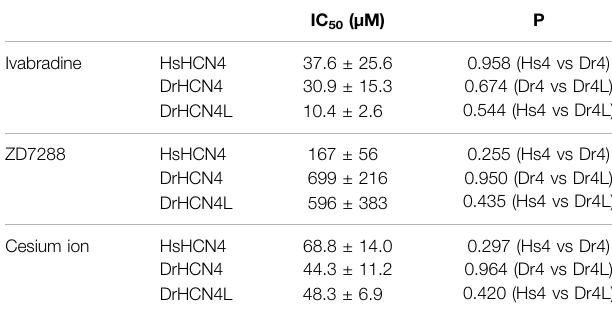
TABLE 4 | IC 50 ( μ M) and p -values for the HCN4